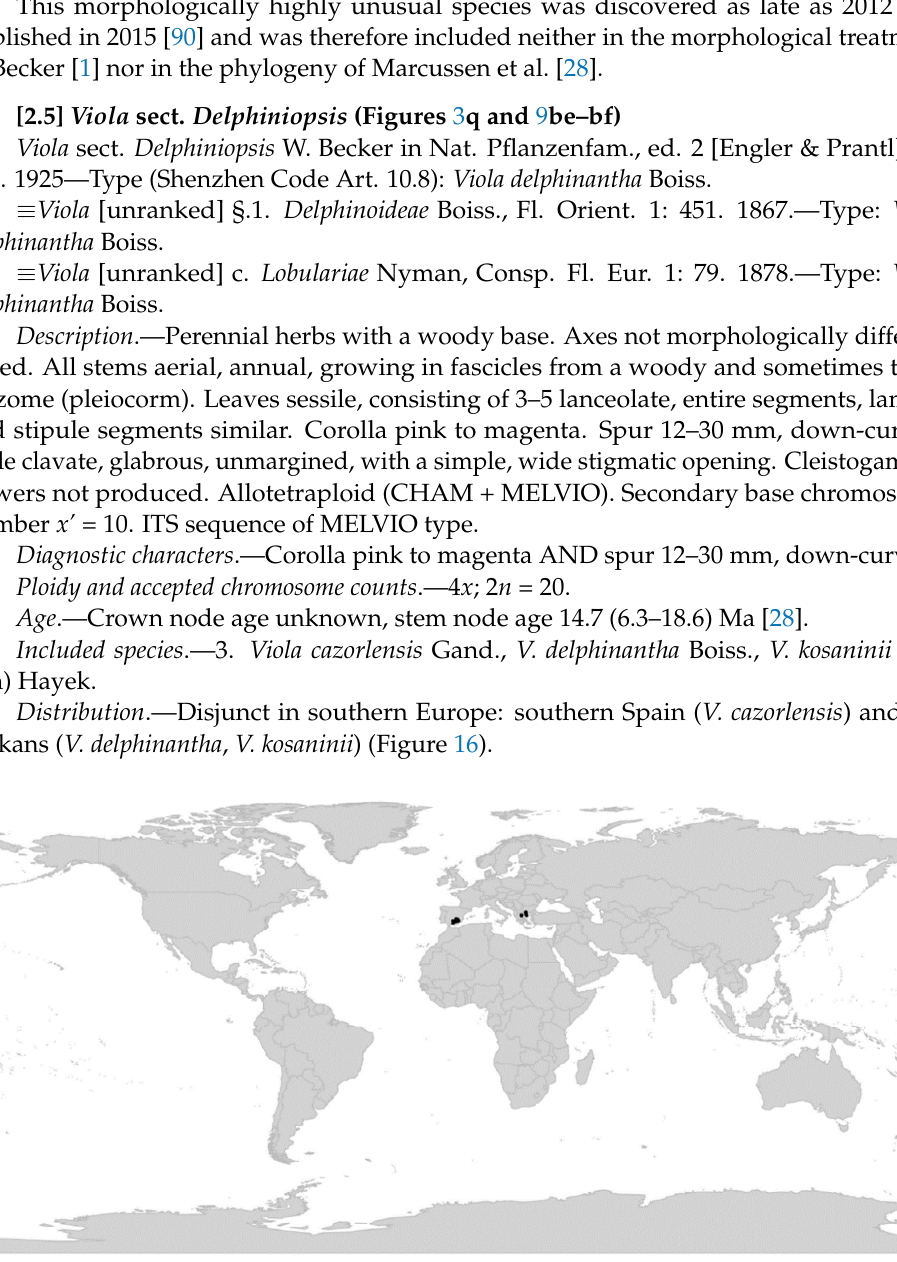
Figure 16. Global distribution of Viola sect. Delphiniopsis .